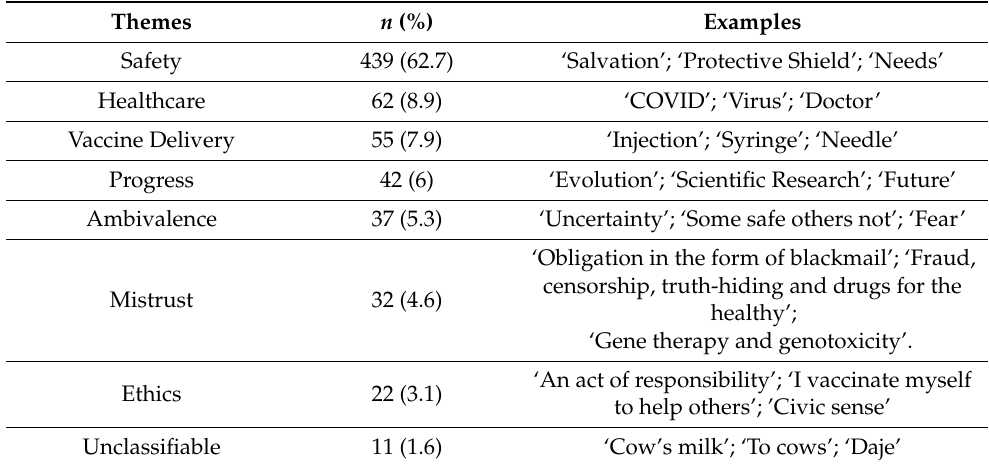
Table 2. Frequency of categories in the total